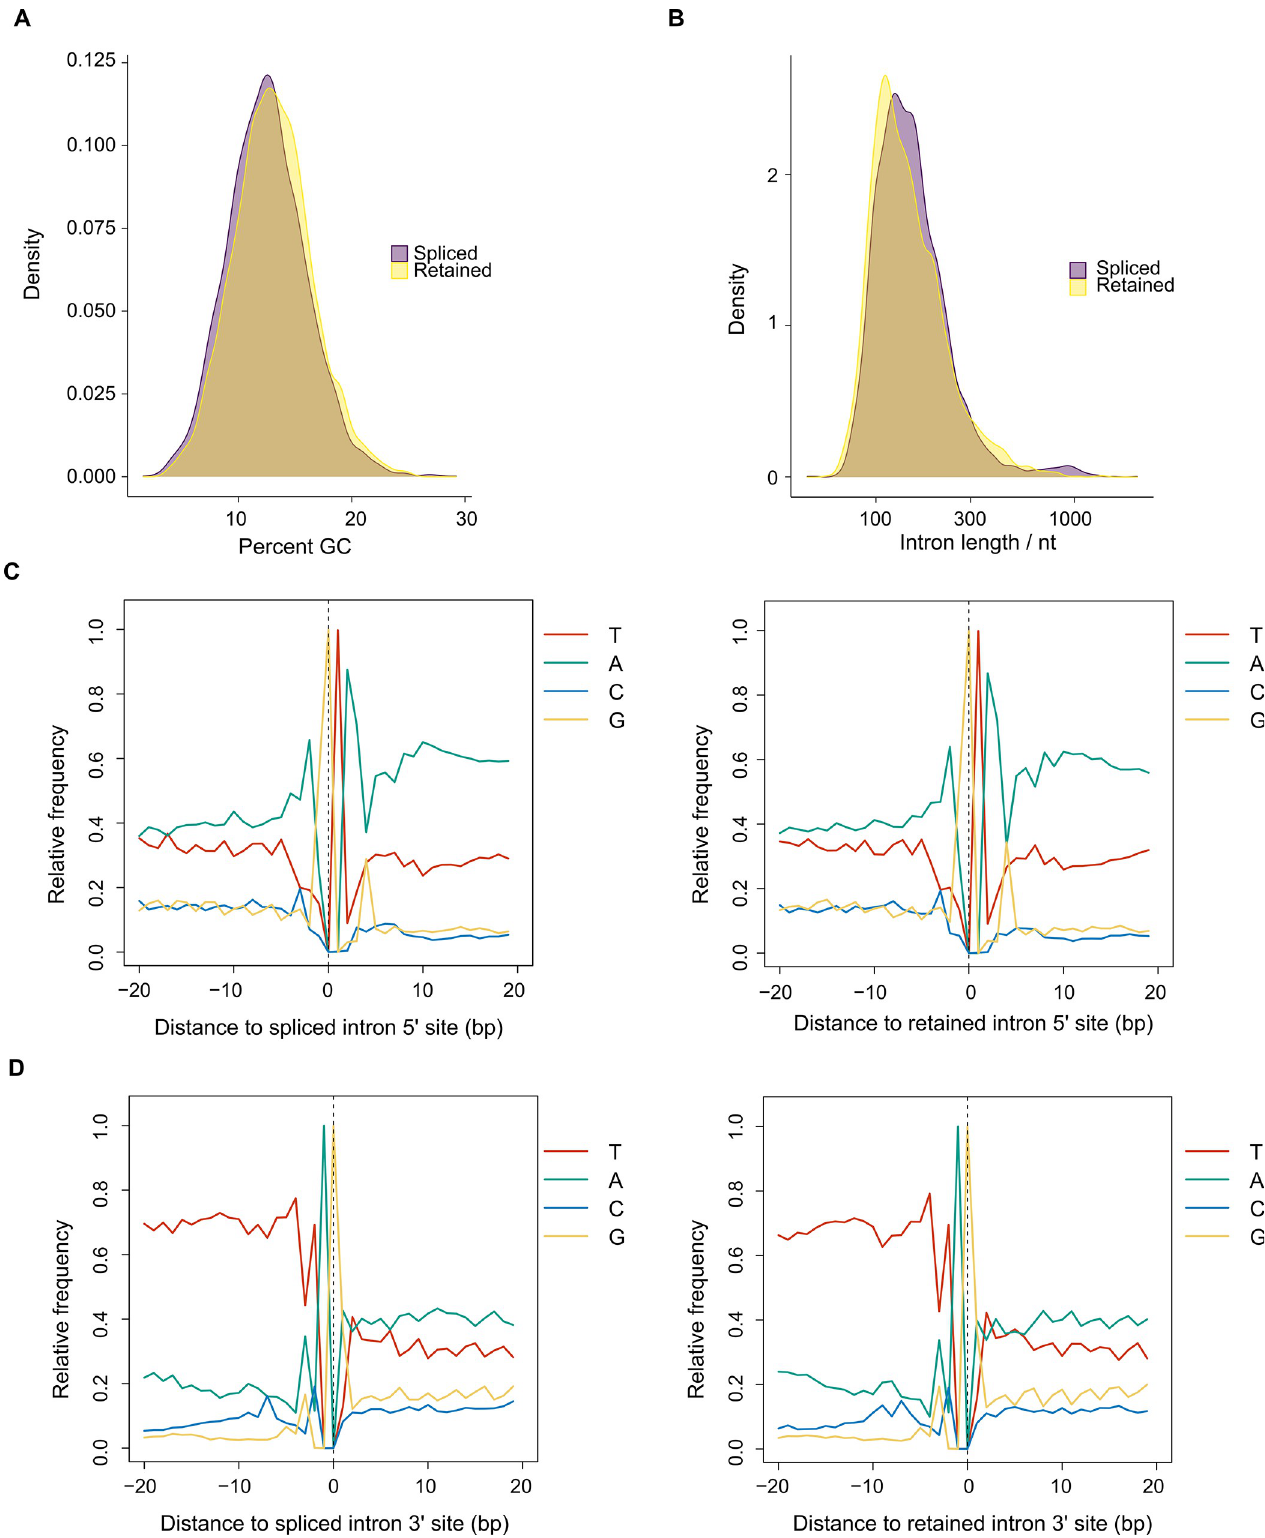
Fig 5. Analysis of retained introns identified in novel isoforms. Genomic sequences of retained introns in Plasmodium falciparum 3D7 novel isoforms (2,710) were compared with spliced introns (6,258). (A) Distribution of intron sequence percent GC content as shown by kernel density plot, in which the